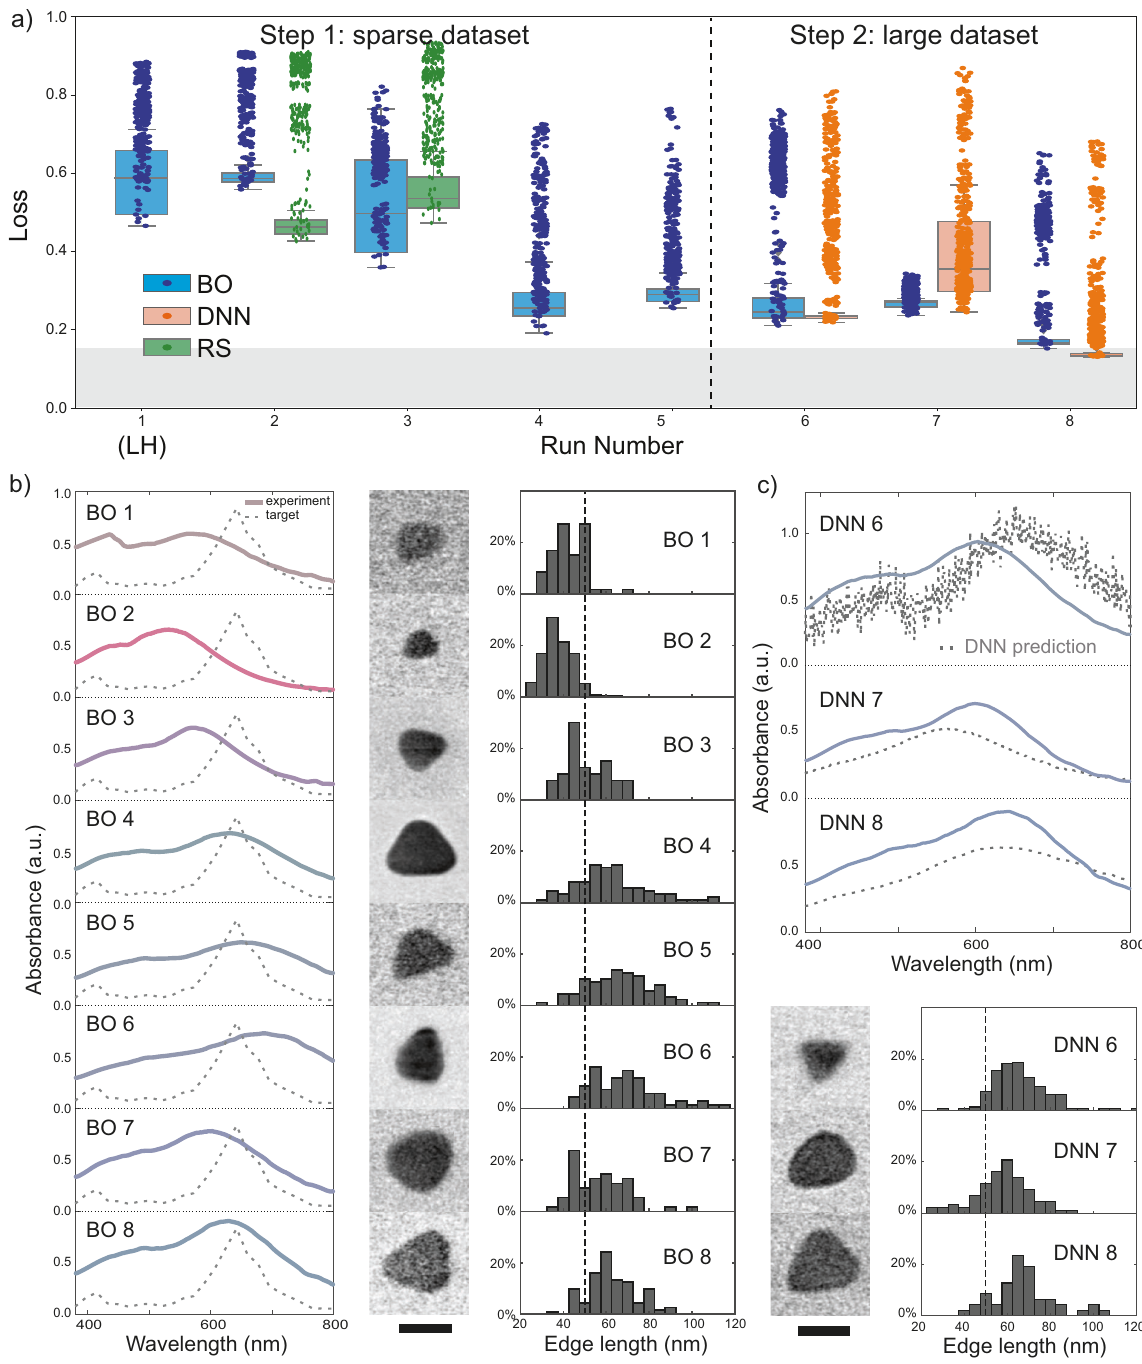
Fig. 2 Optimization performance. a Evolution of the loss for the conditions suggested by RS (green), the BO (blue) and the DNN (orange): each point represents a droplet. For each run, the condition giving the lowest loss is identi fi ed as the best performer. The box plots show the distribution of the loss values for all the droplet samples of the run, and the grey zone indicates the minimal loss value to reach before stopping the HTE loop. The absorbance spectra of the BO ( b ) and DNN ( c ) best performers, with the associated size distribution of triangular prisms in solution, show that the chosen loss function allows a convergence of the spectra towards the target spectrum and the prisms towards a triangle edge of 65 nm. The colours of the absorbance spectra indicate the colour of the best performing droplet. The TEM images show nanoprisms with the median edge size found in the sample. The scale bars correspond to 50 preliminary screening of the extended parameter space is target spectrum. The framework is designed to be able to extend performed. Both BO and DNN-based grid optimization use their the parameter space if the suggested conditions are too close to knowledge on the initial parameter space to start exploring the the set boundaries for two successive runs. This situation occurs in extended space. This extension allows a further decrease in the runs 4 and 5. Thus, starting from run 6, the fl ow rate constraints median loss of the best performing conditions obtained by BO are relaxed to the maximal values allowed by the equipment. No